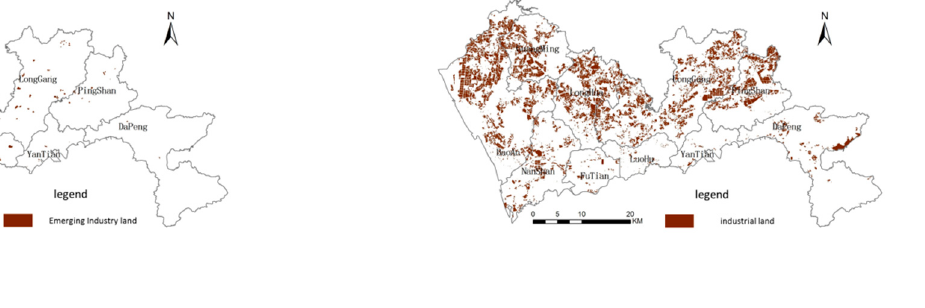
Figure 2. Grid map of the factors of the dependent variables.